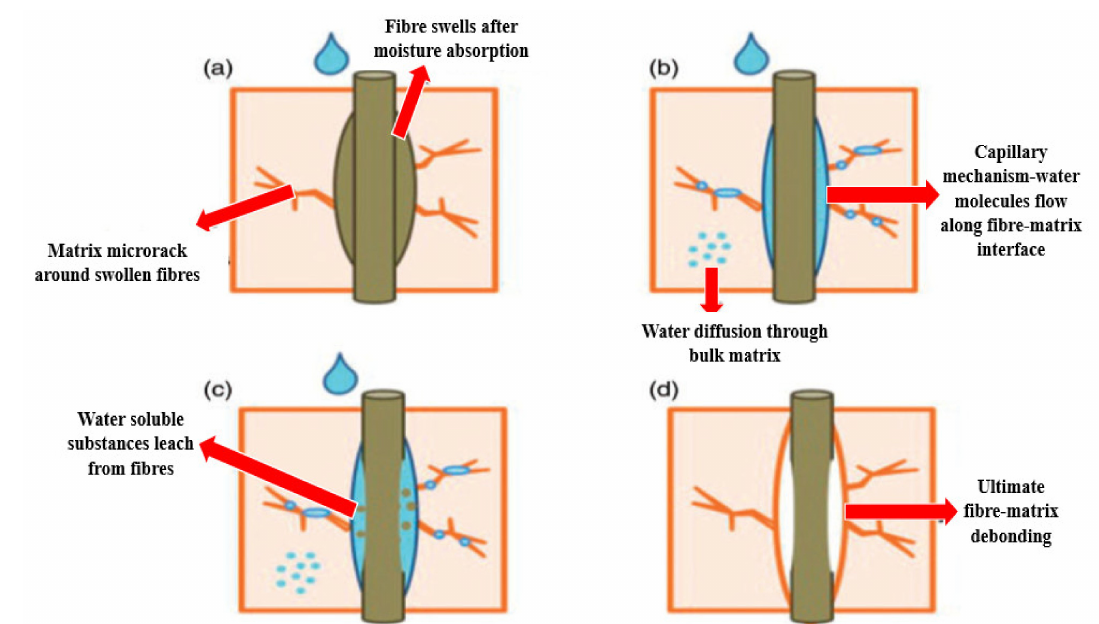
Figure 1. Effect of water absorption of natural fiber on mechanical properties of composite laminate:( a ) fibre swells after moisture absorption,( b ) capillary mechanism water molecules flow along fibre-matrix interface, ( c ) water soluble substance leach from fibres, and ( d ) ultimate fibre-debonding